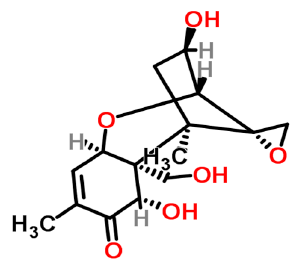
Figure 5. Deoxynivalenol (structure from www.chemspider.com).